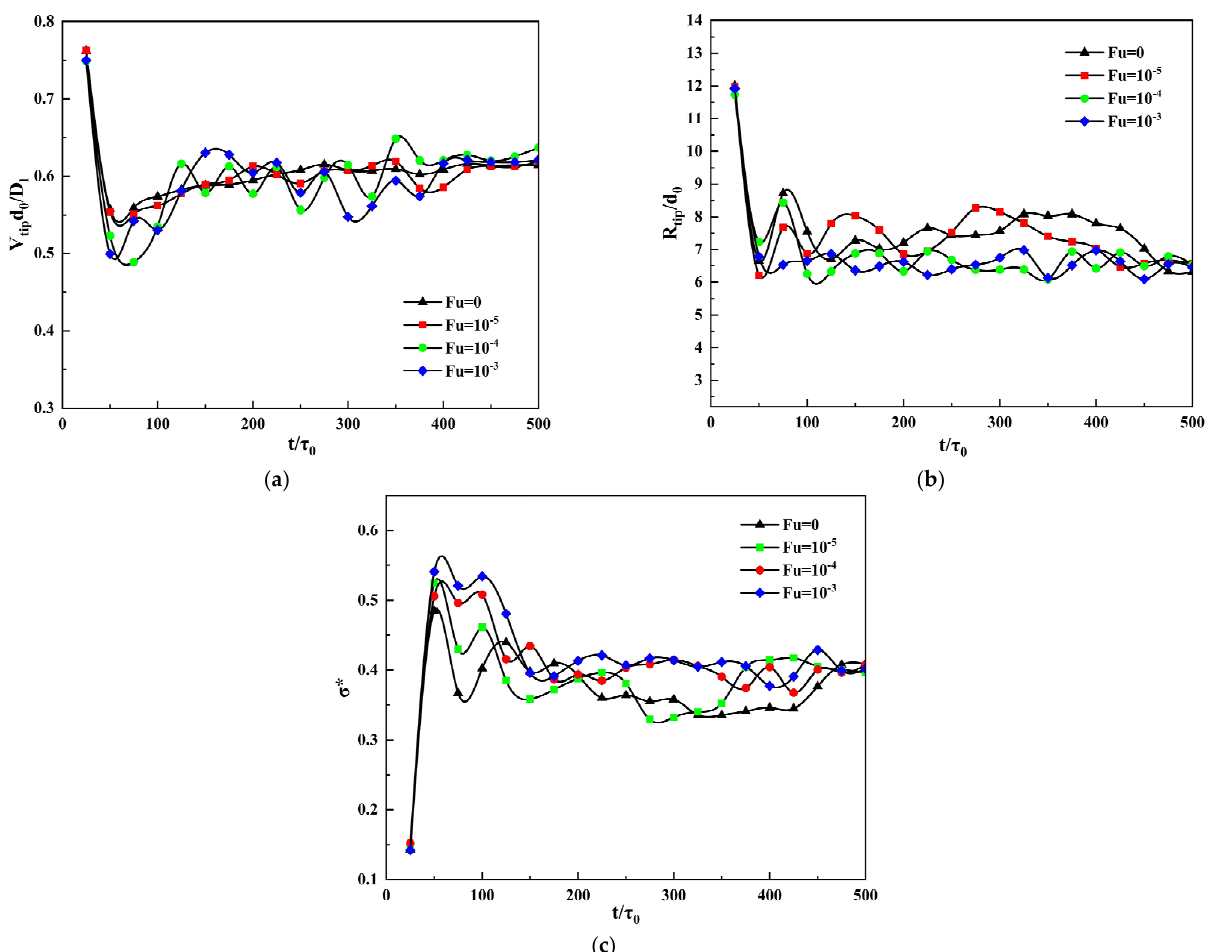
Figure 7. The curve of dendrite tip parameters changes with simulation time under different thermal disturbances. ( a ) Tip velocity; ( b ) Tip radius; ( c ) Steady-state coefficient.